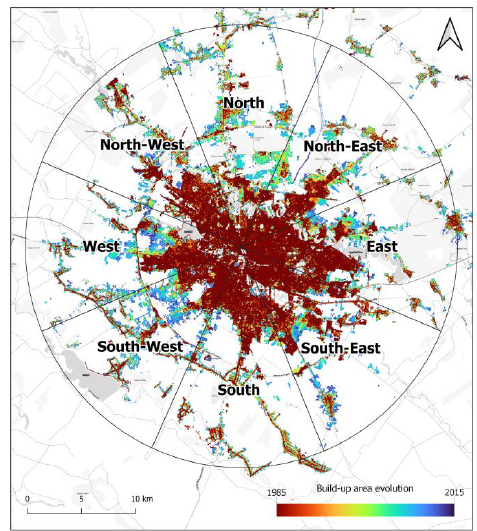
Figure 9 . Urban expansion of Bucharest between 1985 and 2015 by cardinal and ordinal directions